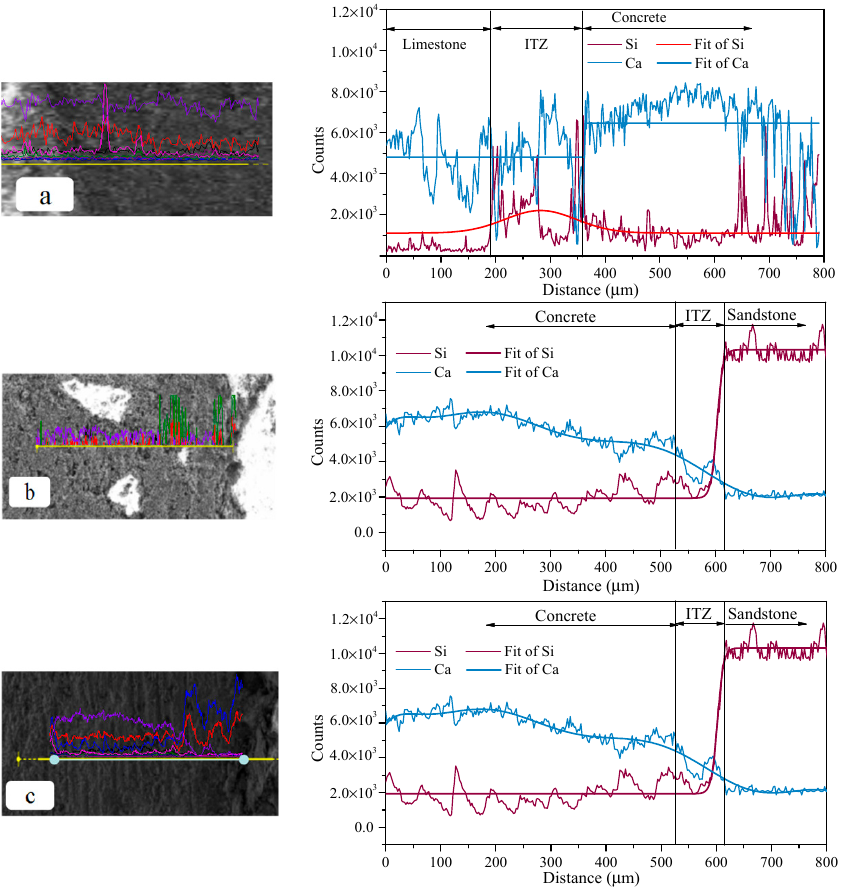
Figure 8. Comparison of SEM-EDS test results of concrete–rock interface; ( a ) limestone–concrete; ( b ) granite–concrete; ( c ) sandstone–concrete).